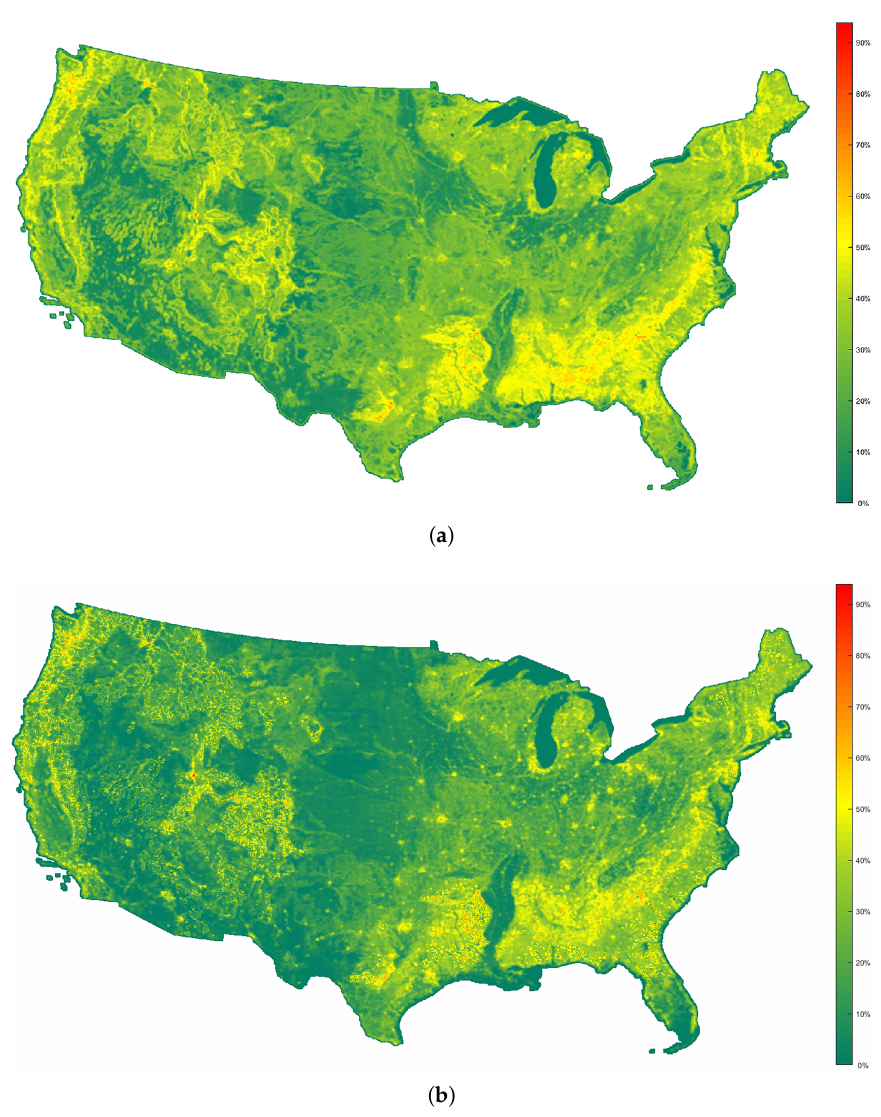
Figure 19. Similarity maps (with a resolution of 3 km) for reference scene III. ( a ) The proposed method. ( b ) The method proposed in [28].